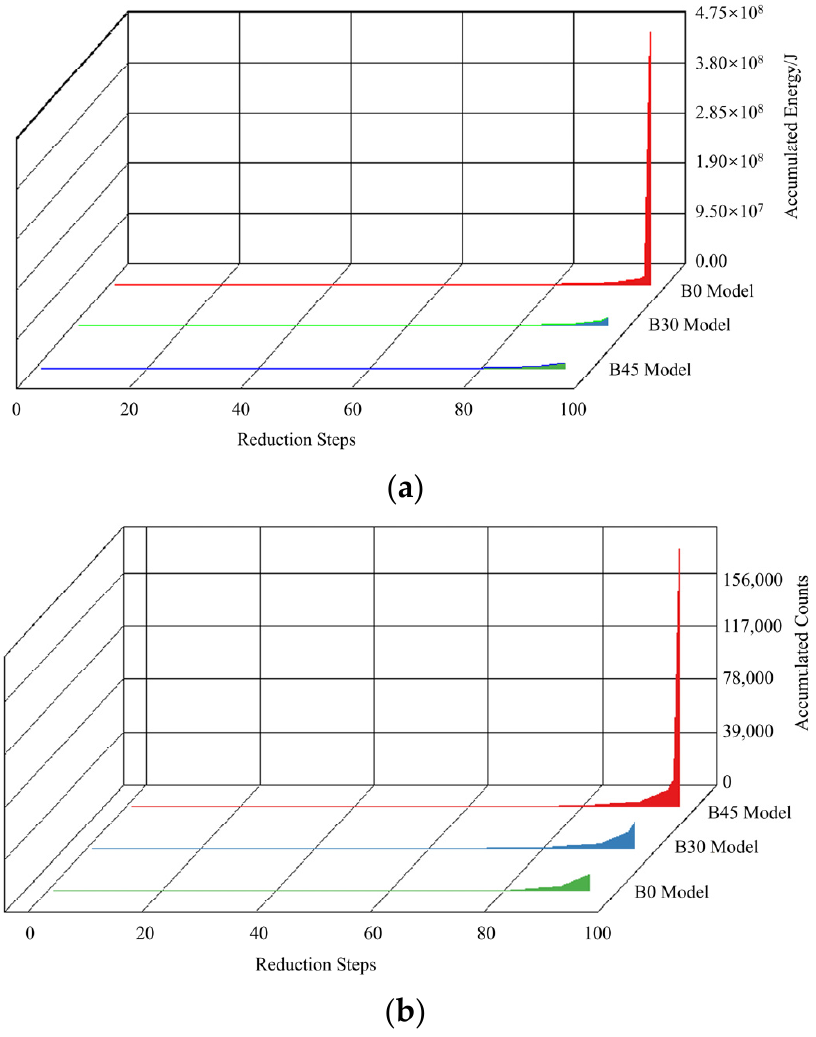
Figure 11. Comparison of acoustic emission in different models: ( a ) accumulated acoustic emission energy; ( b ) accumulated acoustic emission counts.